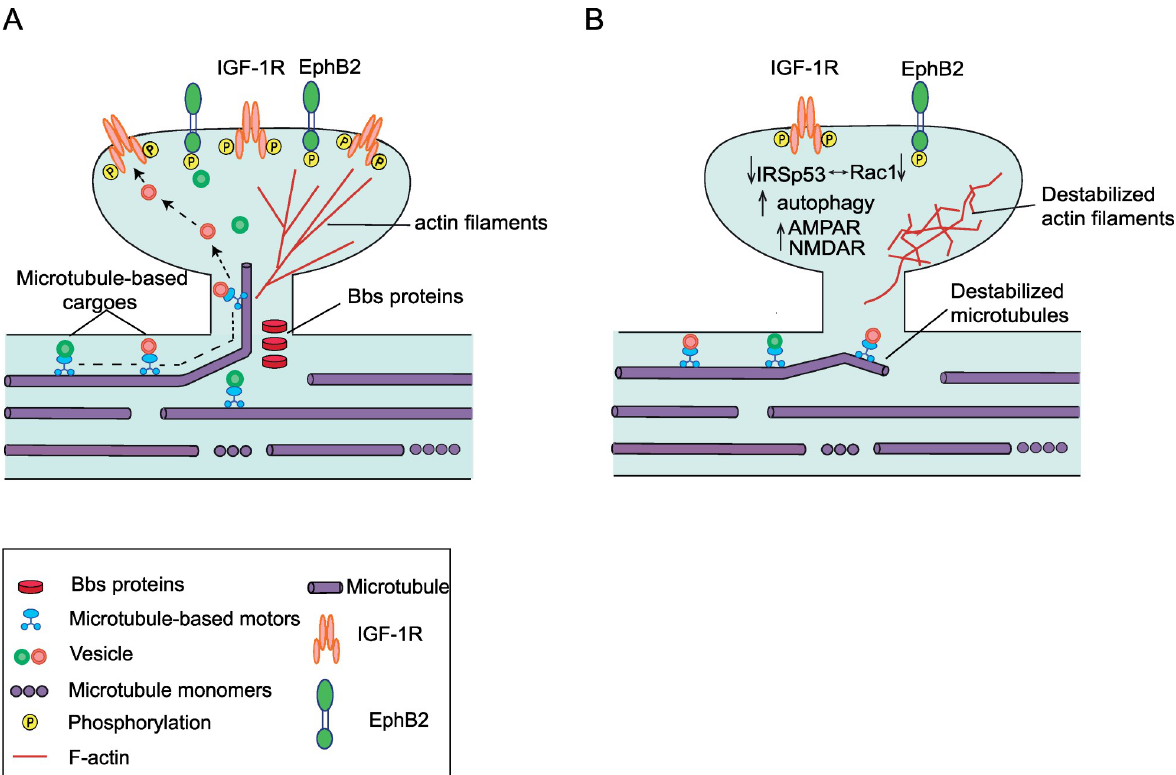
Fig 6. Working model of the role of Bbs proteins in synapses. This simplified schematic is based on (i) the data shown in this paper, (ii) the previously described role of Bbs proteins in primary cilium, and (iii) known dendritic spine homeostasis. It illustrates possible mechanisms by which Bbs proteins may impact synapse plasticity. (A) In the presence of Bbs proteins at the dendritic shafts, microtubules are anchored, facilitating receptor transport to the plasma membrane of the spines. Bbs proteins may also be involved in the transport of the receptors in and out of the spine membrane. (B) In the absence of Bbs proteins the microtubule anchoring and receptor sorting may be destabilised. The receptor transport to the spines becomes dependent on other transport mechanisms, e.g., exocytosis of vesicles in the dendritic shafts or a myosin-based transport [46]. This may result in reduction of the spine membrane receptor abundance (e.g., IGF-1R). This may trigger a number of downstream events, leading to destabilisation of actin filaments and eventually dendritic spines. AMPAR, alpha-Amino-3-Hydroxy-5-Methyl-4-Isoxazole Propionic Acid receptor; Bbs, Bardet-Biedl syndrome; EphB2, ephrin B 2; IGF-1R, insulin-like growth factor; NMDAR, N-methyl-D-aspartate receptor.